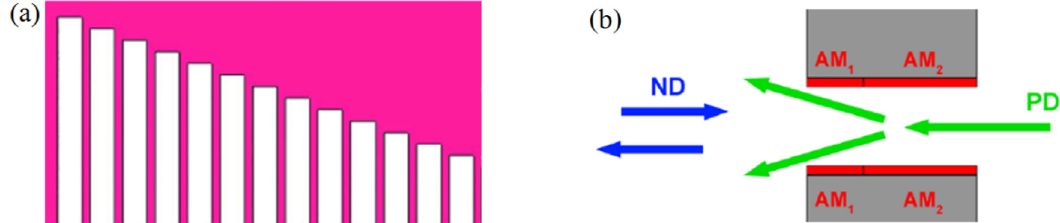
Fig. 2. (a) AMS with tapered rectangular grooves. (b) Schematic of acoustic one-way tunnel with multiple